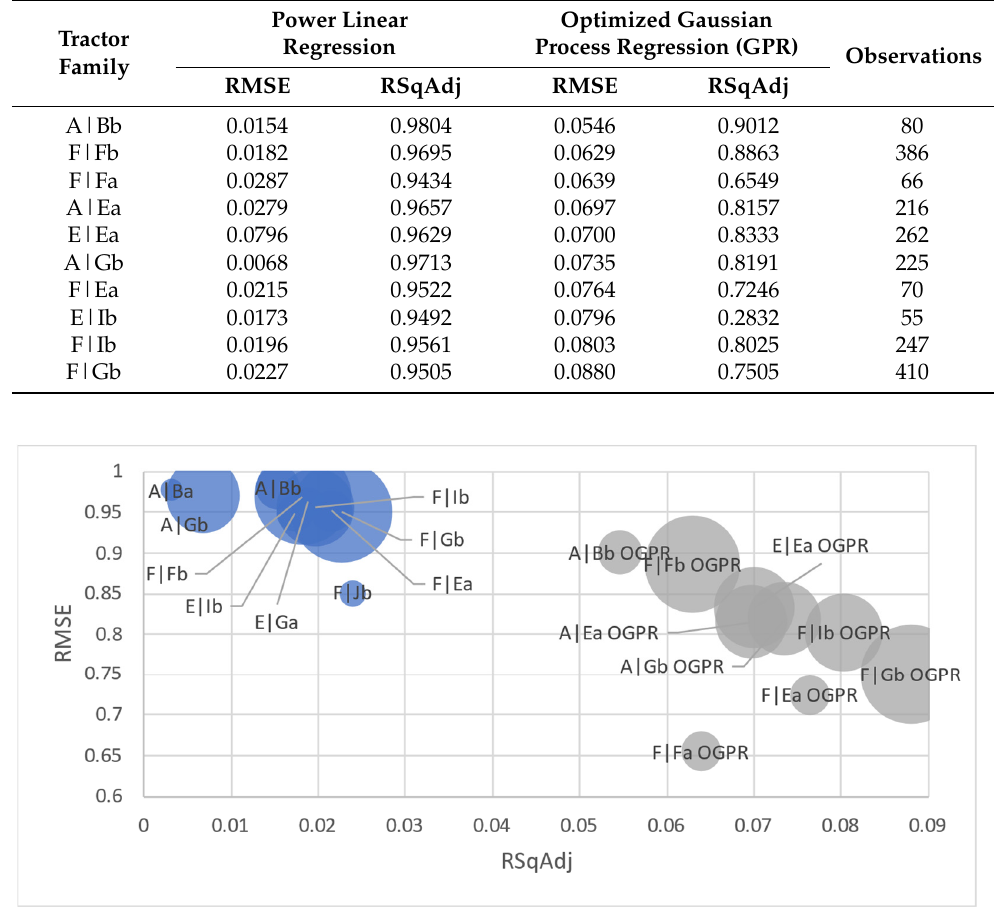
Figure 7. Two predictors, grouped by family power regression (blues) and OGPR (grey) results (bubble size represents number of